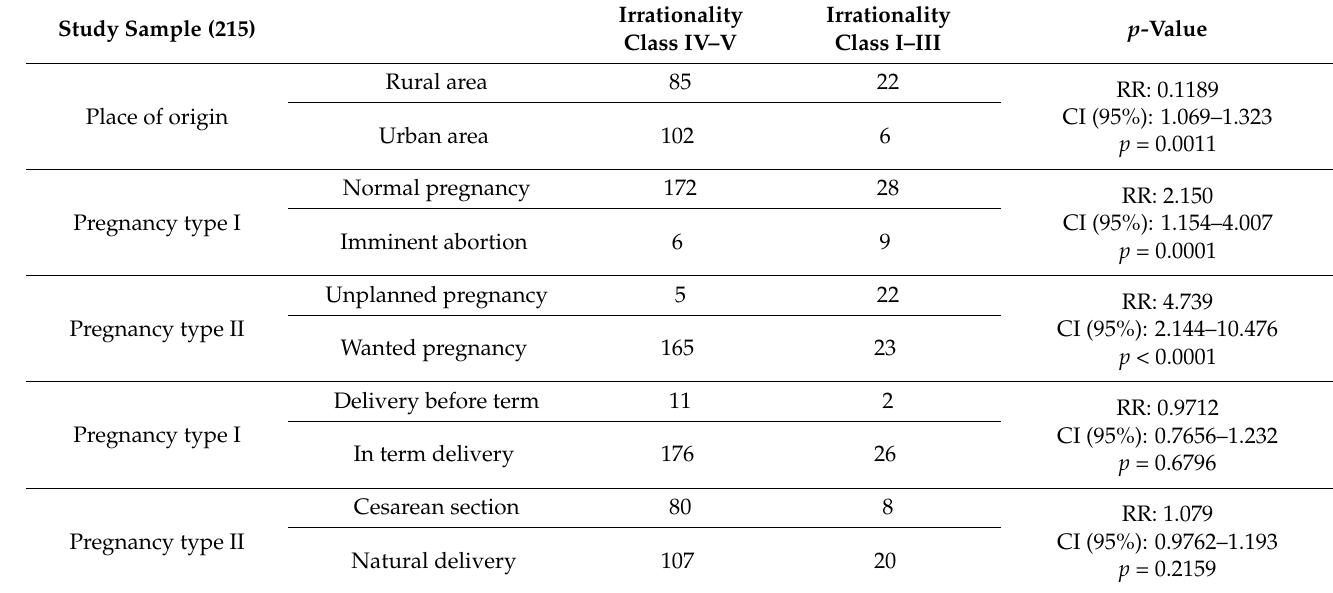
Table 4. Irrationality class IV–V vs. irrationality class I–III